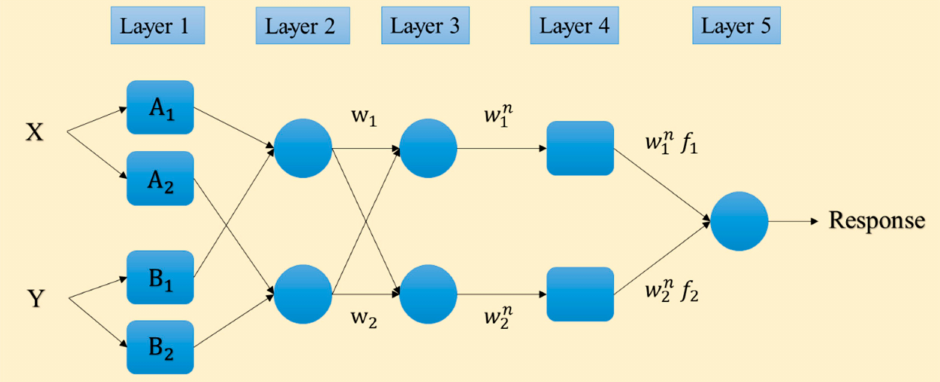
Figure 3. Typical structure of the ANFIS